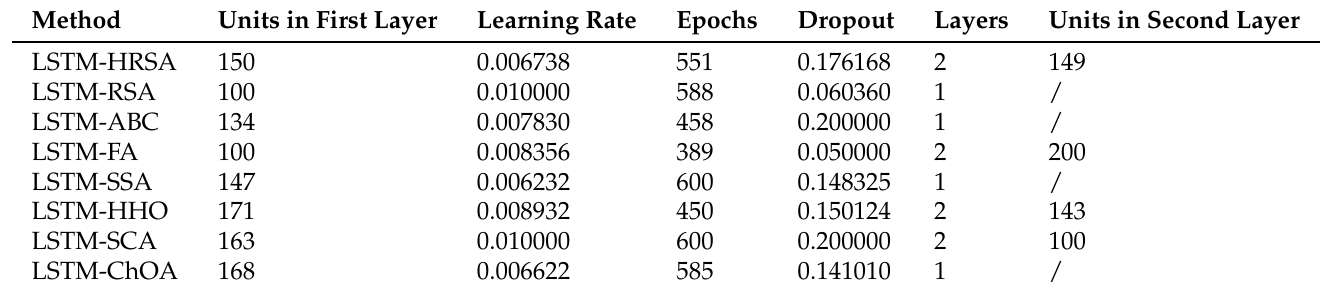
Table 4. Best attained collection of LSTM parameter values by each observed algorithm.